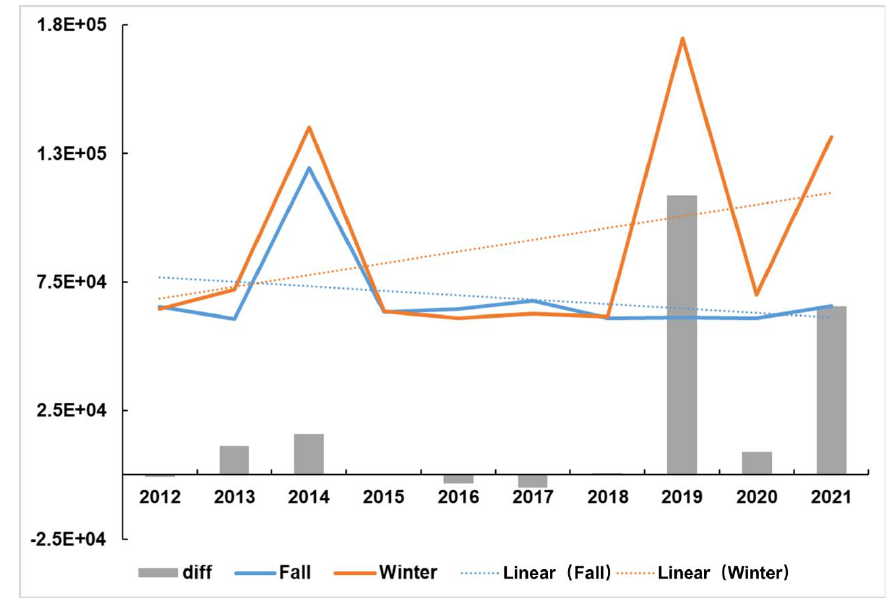
Figure 11. Snow/ice cover areas of Svalbard, Arctic region, from 2012 to 2022.